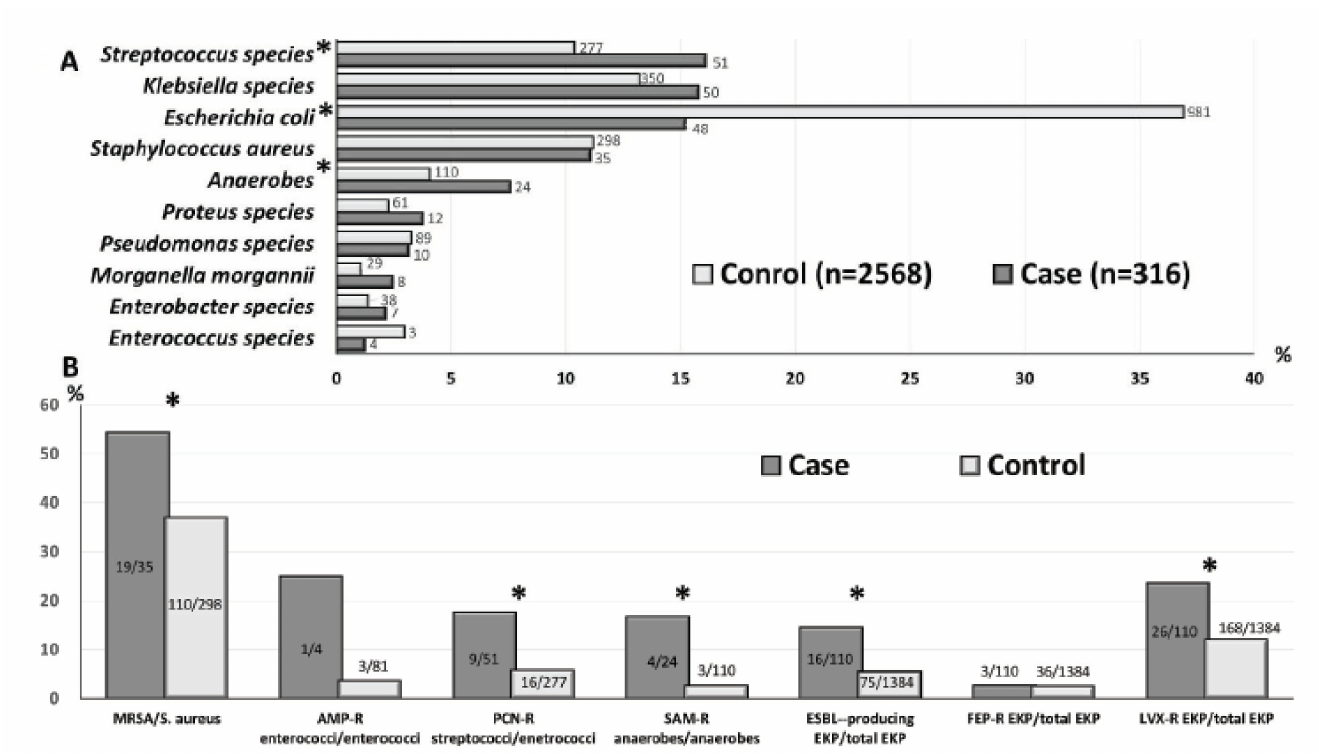
Figure 2. Distribution of the leading ten microorganisms ( A ) # and antimicrobial-resistant microorganisms ( B ) § between the case and control patients. AMP = ampicillin; EKP = Escherichia coli , Klebsiella species, and Proteus mirabilis ; ESBL = extended- spectrum beta-lactamase; LVX = levofloxacin; MRSA = methicillin-resistant Staphylococcus aureus ; PCN = penicillin; R = re- sistant; SAM = ampicillin/sulbactam. * indicates a significant difference (i.e., p < 0.05) between the case and control patients. # Numbers in the bar indicate the isolate numbers. § The denominators and numerators, respectively, indicate the isolate numbers of all microorganisms and antimicrobial-resistant